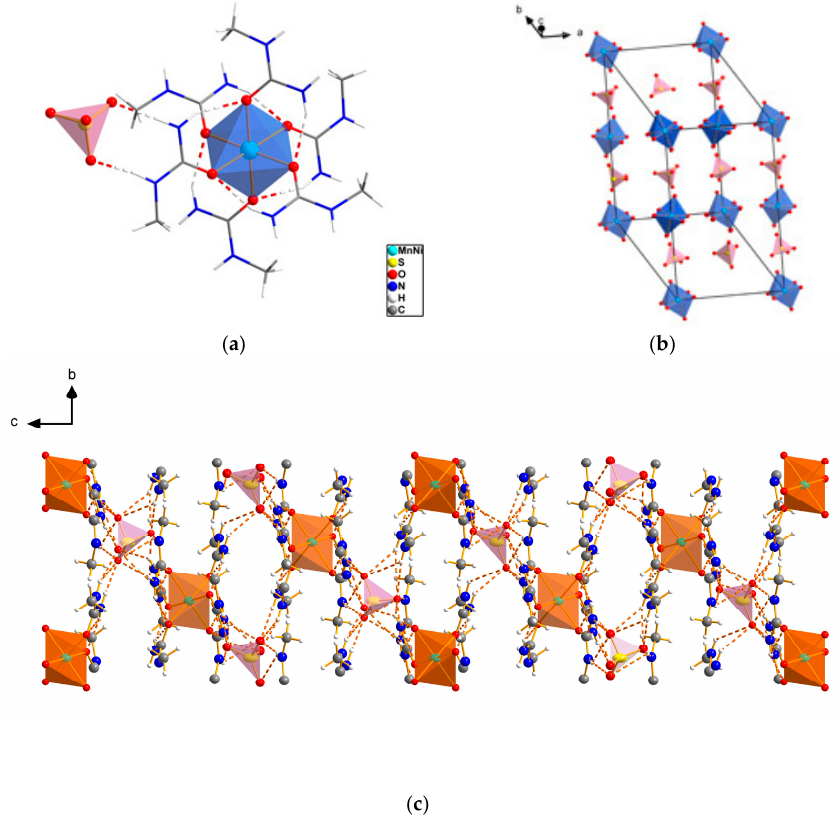
Figure 2. ( a ) The coordination polyhedral aroundNi 2+ /Mn 2+ in (I), (II), (III), and (IV); ( b ) packing diagram for (I), (II), (III), and (IV); C, H, N atoms have been omitted for clarity; ( c ) packing diagram for (I), (II), (III), and (IV); viewed along [100].